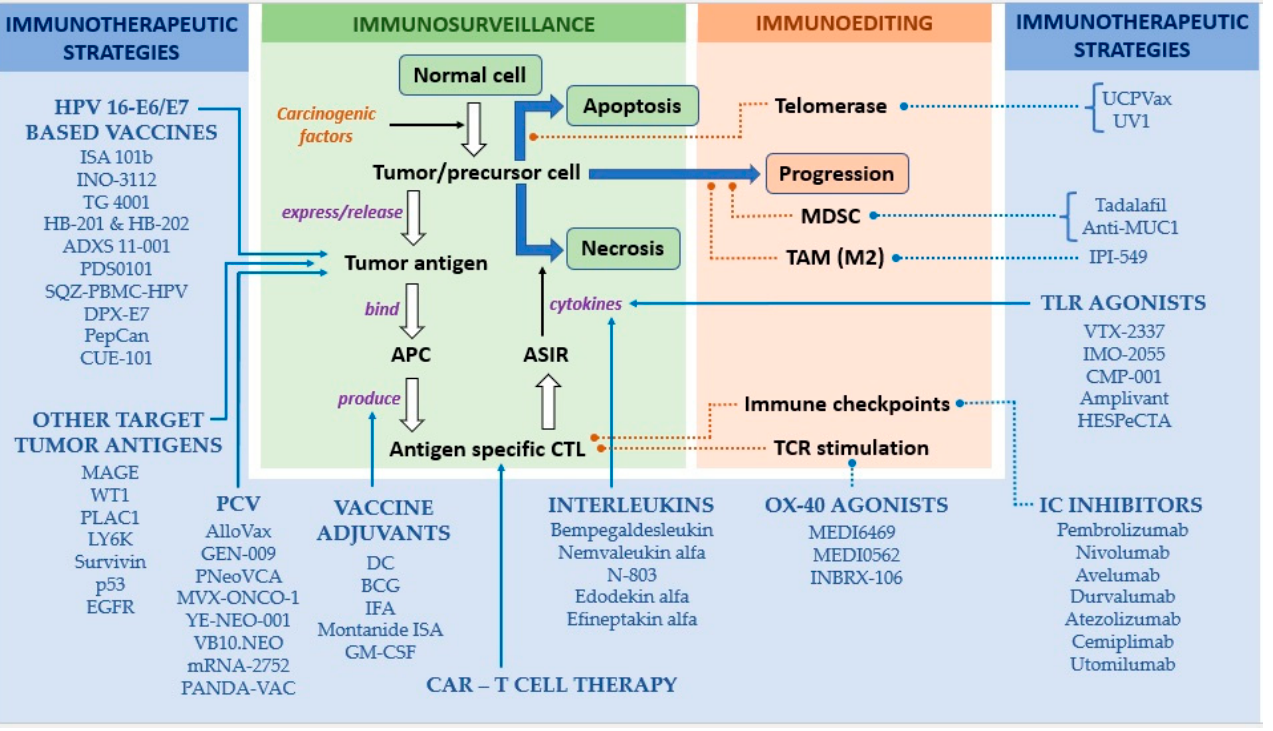
Figure 1. Immunological basis, approachs and agents of therapeutic vaccination in HNSCC. For abbreviations and further details, kindly refer to the Section 3 of